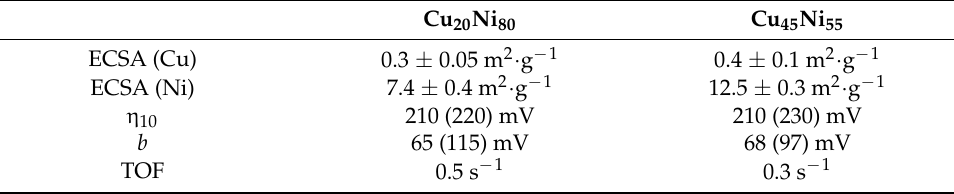
Table 1. ECSA, overpotential at − 10 mA · cm − 2 ( η 10 ), Tafel slope ( b ), and TOF values for the deposited Cu 20 Ni 80 and Cu 45 Ni 55 surface-mesostructured films. The ECSA values are given for Cu and Ni elements separately. Values in parentheses correspond to plain films of same